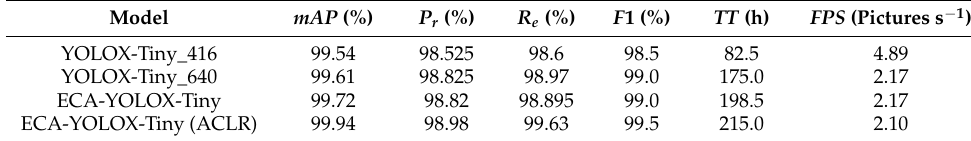
Table 3. The training results of different